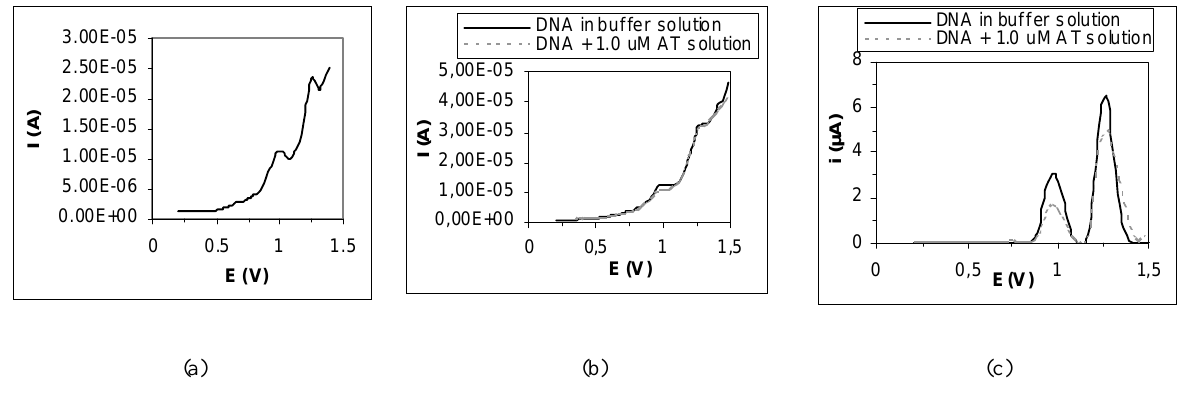
Figure 2. Redox behavior of guanine (+1.0 V vs. Ag – SPE) and adenine (+1.25 V vs. Ag – SPE) bases after a square wave voltammetric scan carried out with graphite screen printed working electrode. It can be noted the normal signal (a), the decrease of the DNA peaks after the interaction with a 1.0 µ M 2-anthramine standard solution (b) and the signals after a baseline correction (c). Electrode pre-treatment: +1.6 V ( vs. Ag – SPE) for 120 s and +1.8 V ( vs. Ag – SPE) for 60 s in 5 mL of 0.25 M acetate buffer containing 10 mM KCl (pH = 4.75) under stirred conditions; DNA immobilisation: 50 ppm Calf thymus dsDNA (in 0.25 M acetate buffer with 10 mM KCl) applying a potential of +0.5 V ( vs. Ag – SPE) for 5 min under stirred conditions; blank or sample interaction: 10 µL of the sample solutions onto the working electrode surface for 2 min; final measurement: square wave voltammetric scan in 0.25 M acetate buffer containing 10 mM KCl from +0.2 V to +1.35 V (E = 15 mV, E = 40 mV, frequency = 200 Hz). step amplitude